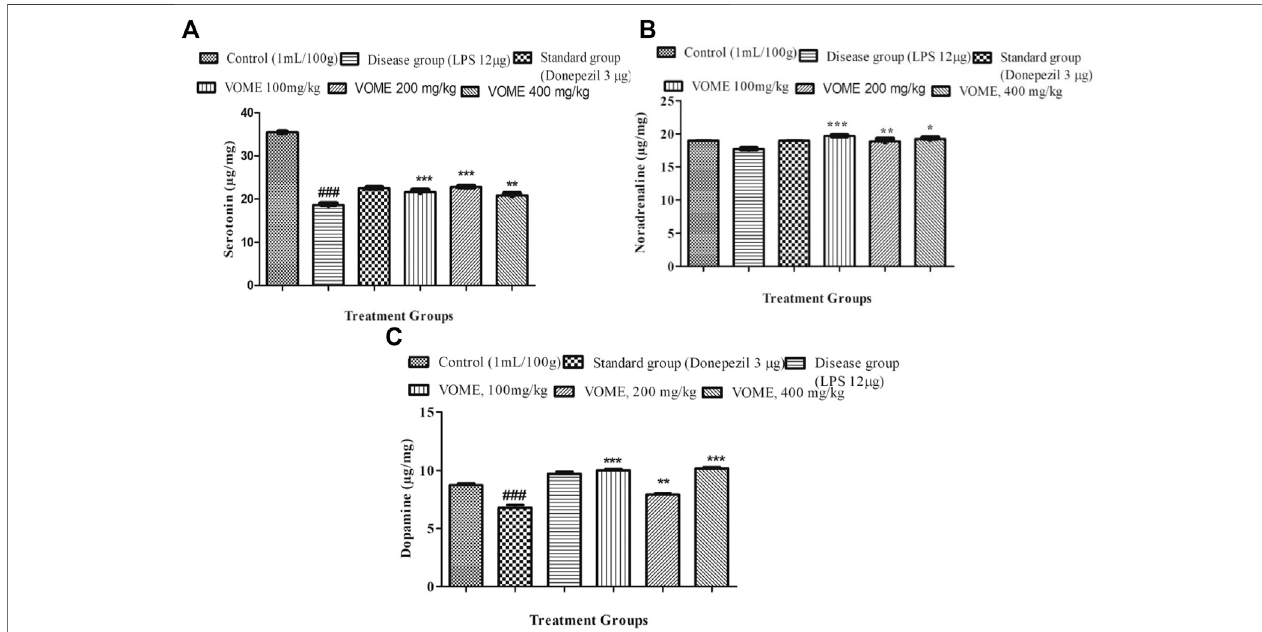
FIGURE 7 | Effect of Viola odorata methanolic extract on neurotransmitters. (A) Histogram indicating results of the serotonin level in the mice brain. (B) Histogram indicatingresultsofNoradrenalinelevelinthemicebrain. (C) Histogramindicatingresultsofdopaminelevelinthemicebrain.Dataareexpressedasmean ± SEM, n (cid:1) 10. *P < 0.05, ** p < 0.01 and *** p < 0.001 as compared to the LPS-treated group. ### p < 0.001 as compared to the control group.